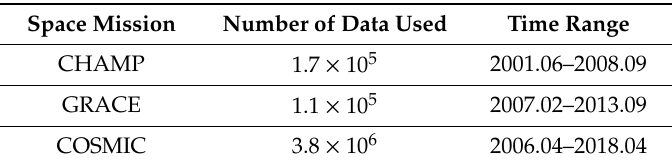
Table 1. Details of the